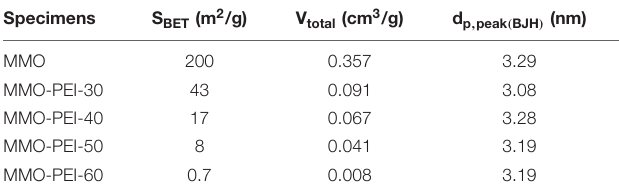
TABLE 2 | Textural properties of pristine MMO and PEI-MMO samples.